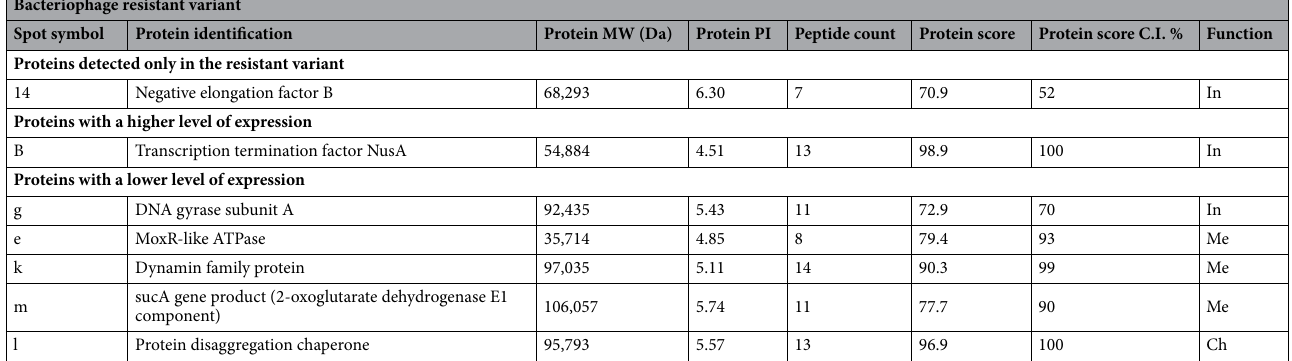
Table 3. Description of proteins specific to studied P. mirabilis 3059 bacteriophage resistant variant (Brsv) identified by MALDI TOF MS/MS. Protein function: In information pathways, Me metabolism, Tr transport, Vi virulence, Ch chaperone. Spots marked with numbers indicate proteins which were detected only in the studied resistant variants. Spots marked with capital or lowercase letters correspond to proteins with a higher or lower level of expression in the resistant variants, respectively.